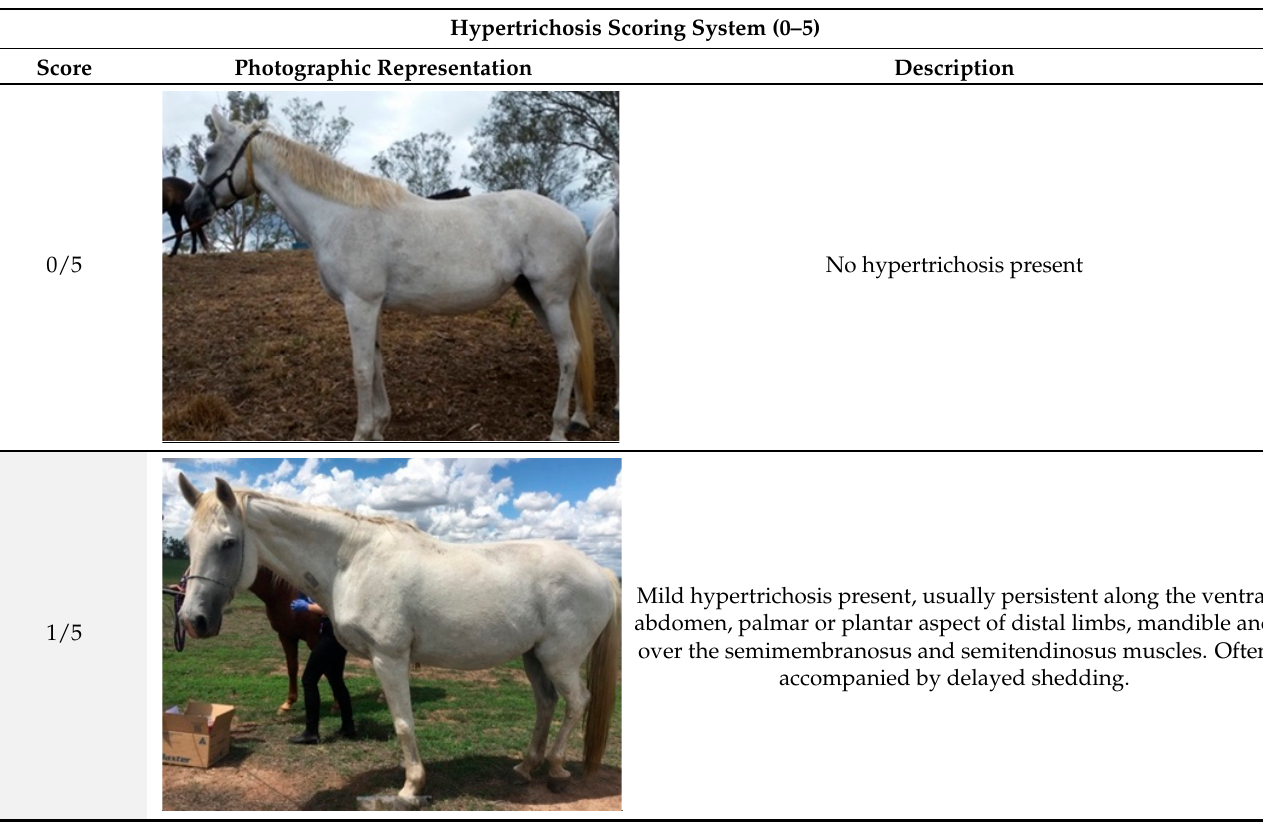
Table 1. Hypertrichosis scoring system with grey scale used to classify severity of clinical signs. The horse pictured (Horse 2) displayed the most marked clinical signs of all included study horses.